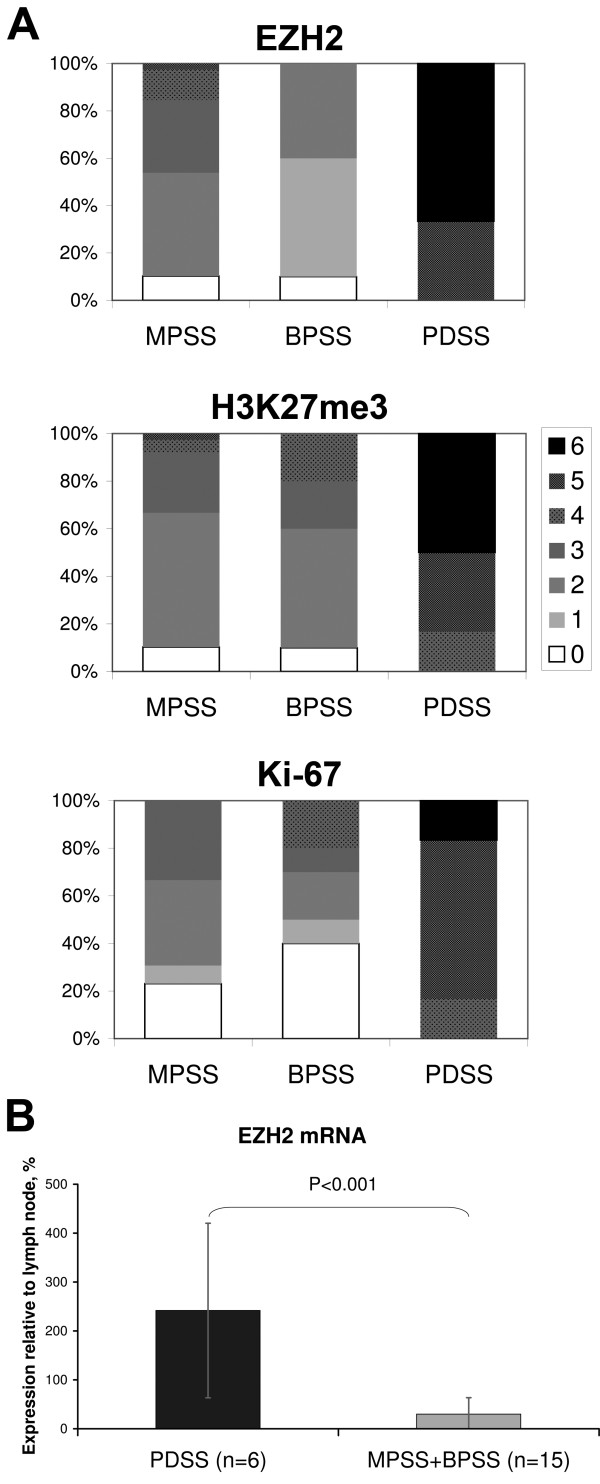
Distribution of scores 0–6 in the MPSS, BPSS, and PDSS subtypes, shown as stacked columns (A). mRNA expression of EZH2 in the PDSS vs. MPSS+BPSS groups, mean Â± S.D. Human ribosomal protein S18 was used as endogenous control and human lymph node was served as calibrator.